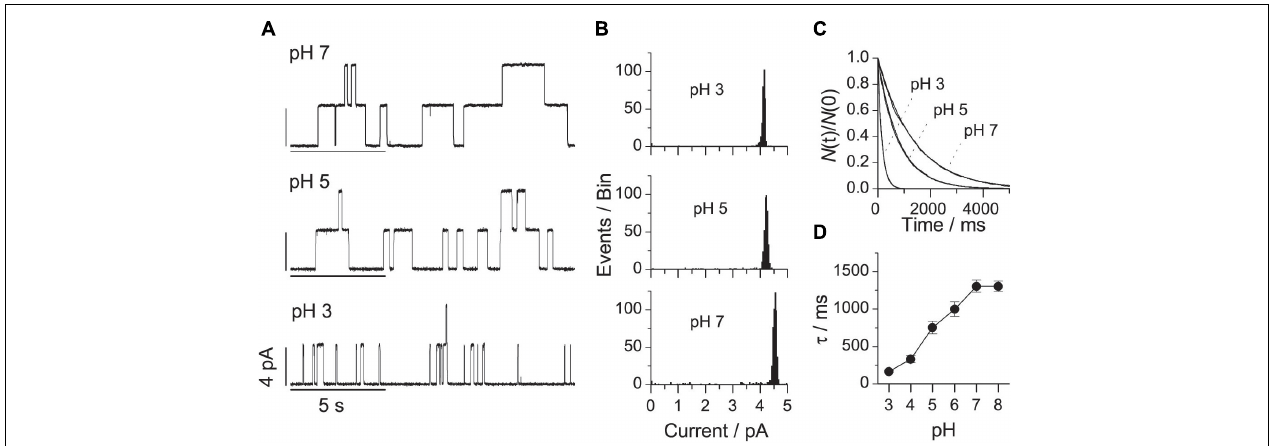
FIGURE 4 | VgA(15) channel function in DOPS/ n -decane bilayers at different pH. (A) Current traces of VgA(15) channels in DOPS/ n -decane bilayers at pH: 7; 5 or 3. (B) Current transition amplitude histograms at pH 7, 5, or 3. (C) The corresponding normalized single-channel duration histograms. Results from single experiments fitted by single exponential distributions. (D) Relation between pH and channel lifetime (mean ± SD, n ≥ 3). 0.1 M NaCl buffered with either Gly-Gly or Na 2 HPO 4 , 200 mV, 100 Hz.